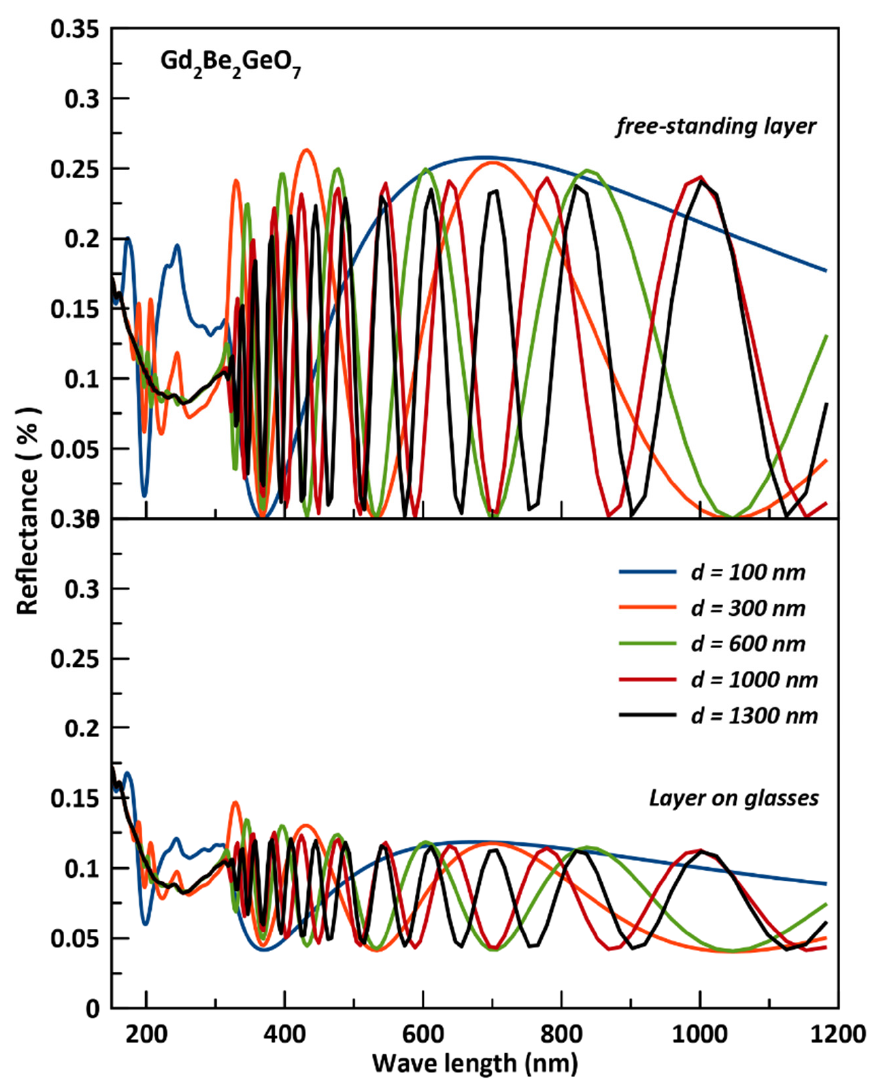
Figure 12. The reflectance spectra of Gd 2 Be 2 GeO 7 thin films with various thicknesses in both coating processes (free-standing layer and layer supported on glasses).